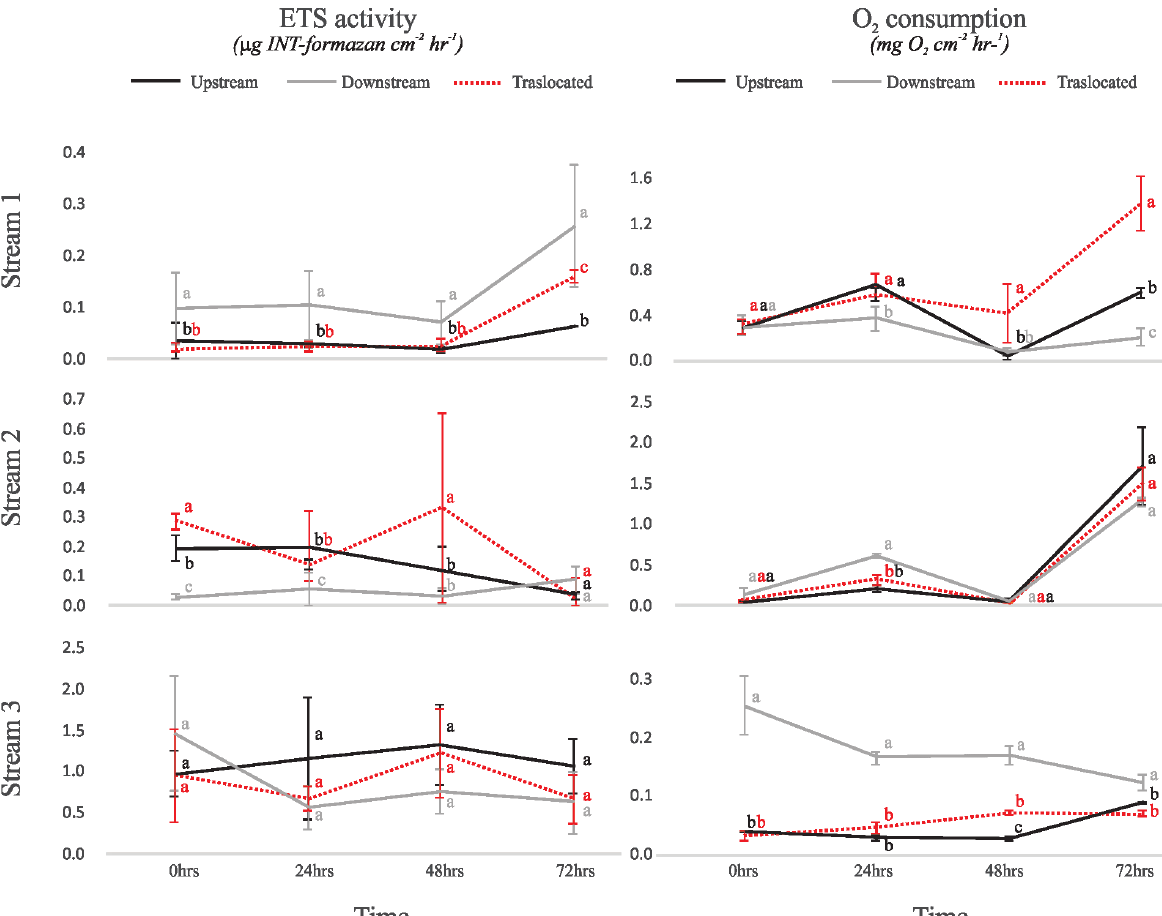
Figure 3. Mean (±SD) ETS activity (µg INT-formazan cm -2 h -1 ) and O experiment in the Upstream (black solid line), Downstream (gray solid lines) and Translocated (red dotted line) treatments. Letters represent groups obtained from the post-hoc statistical analyses at each sampling time comparting between